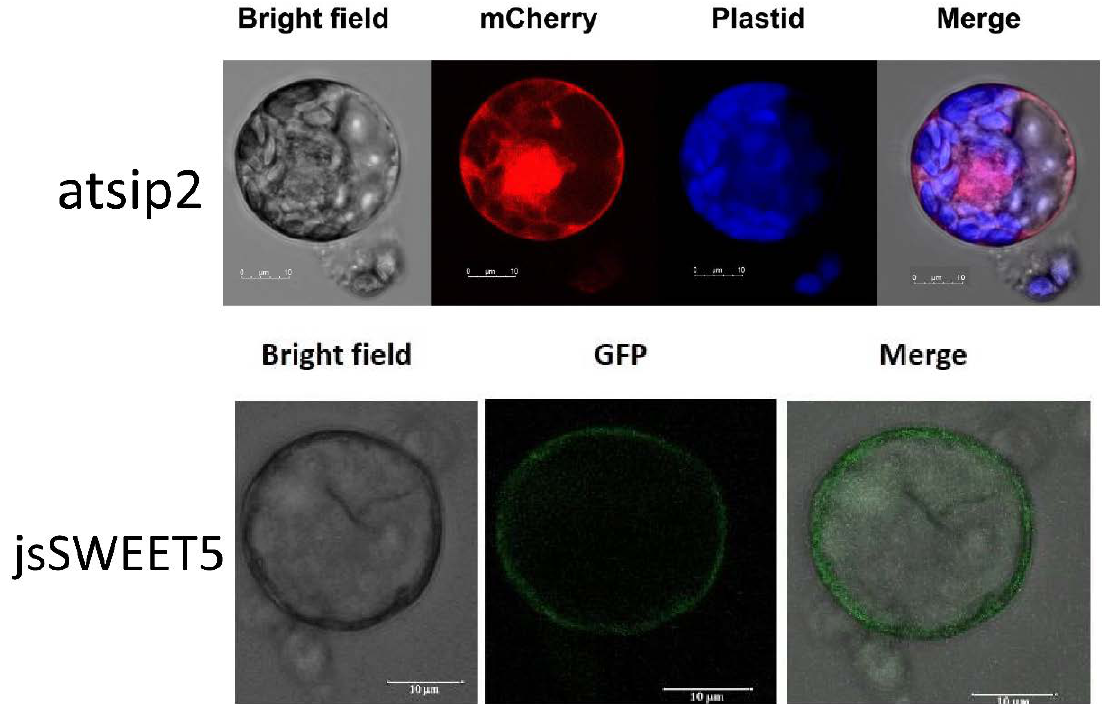
Figure 5. PEG-mediated protoplast transformation and expression in jasmine callus protoplasts. An mCherry-tagged Arabidopsis ER protein AtSIP2 and a GFP-tagged Jasminum plasma membrane protein JsSWEET5 were used as markers for successful expression. The bars represent 10 µm.